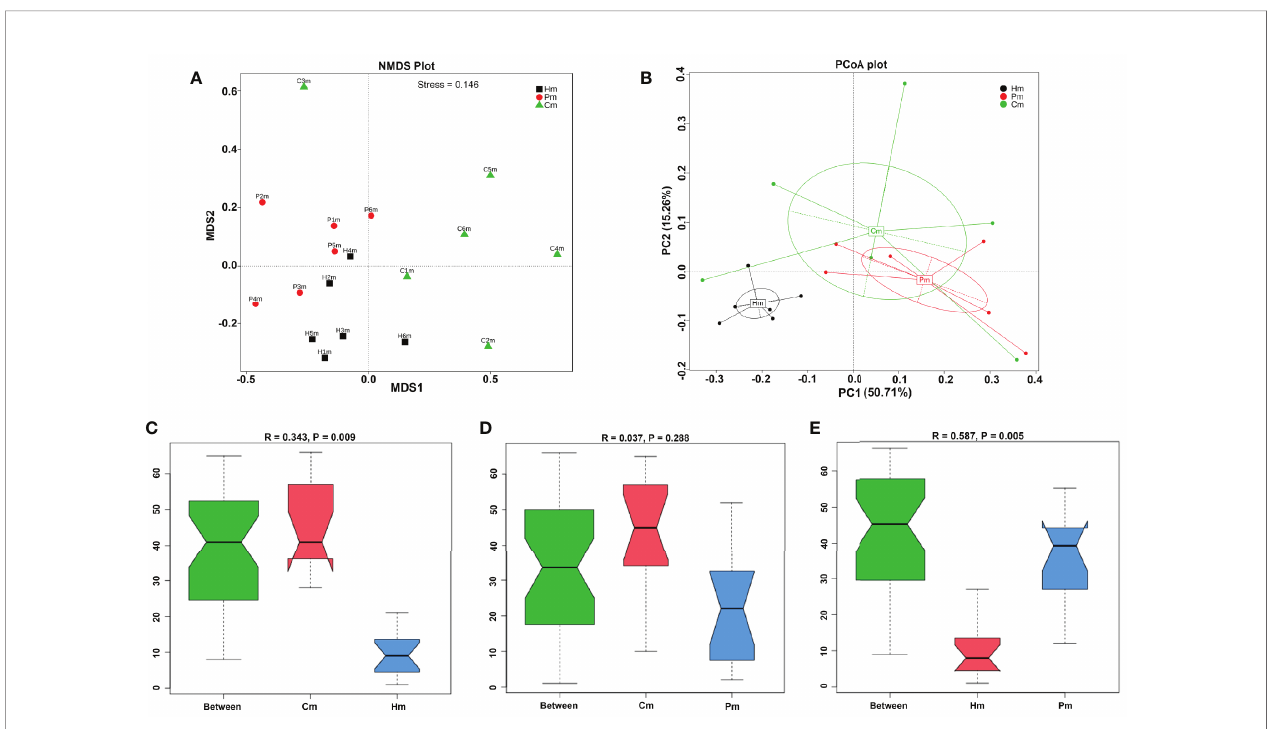
FIGURE 2 | Comparison of the microbial compositions among the various study groups. (A) NMDS plots of the microbiotas in individuals in the Hm, Pm, and Cm groups; the distance between points indicates the degree of variation; a stress value < 0.2 indicates that the NMDS analysis is reliable. (B) PCA plots of the microbiotas in individuals in the three groups, based on Bray – Curtis distances. Samples with high similarity in their community composition tend to cluster together. (C – E) ANOSIM test of whether the difference among groups is signi fi cantly greater than the difference within groups; an R-value < 0 indicates that the intra-group difference is greater than the inter-group difference; p < 0.05 indicates the signi fi cance. Hm, healthy individuals; Pm, patients with periodontitis alone; Cm, patients with Crohn ’ s disease and periodontitis; NMDS, non-metric multidimensional scaling; PCA, principal components analysis; ANOSIM, analysis of